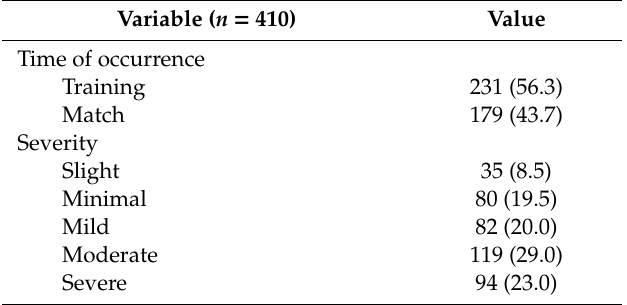
Table 3. Characteristics of injuries in U-15 youth soccer during the 2019